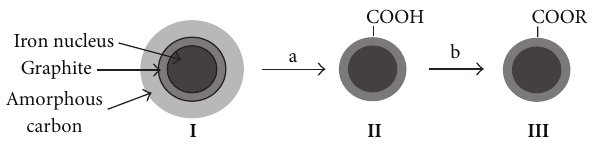
Figure 1: Two-step transformation of the as-synthesized core-shell iron nanoparticles with an amorphous and graphitic carbon coating ( I ) into ester functionalized core-shell nanoparticles ( III ). Step (a), treatment with aqueous HNO 3 , gives particles with a graphitic coating and carboxylic acid functional groups ( II ), and step (b), base and octyl bromide, transforms the acid groups into esters ( III ).